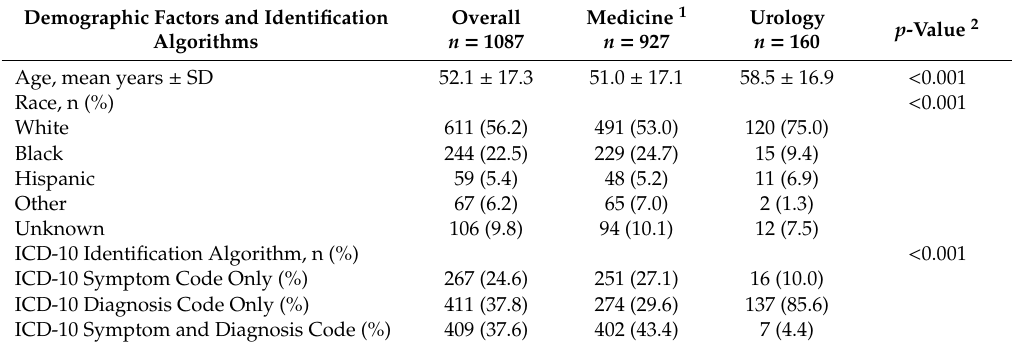
Table 1. Encounter-level patient demographics and urinary tract infection (UTI)-identification